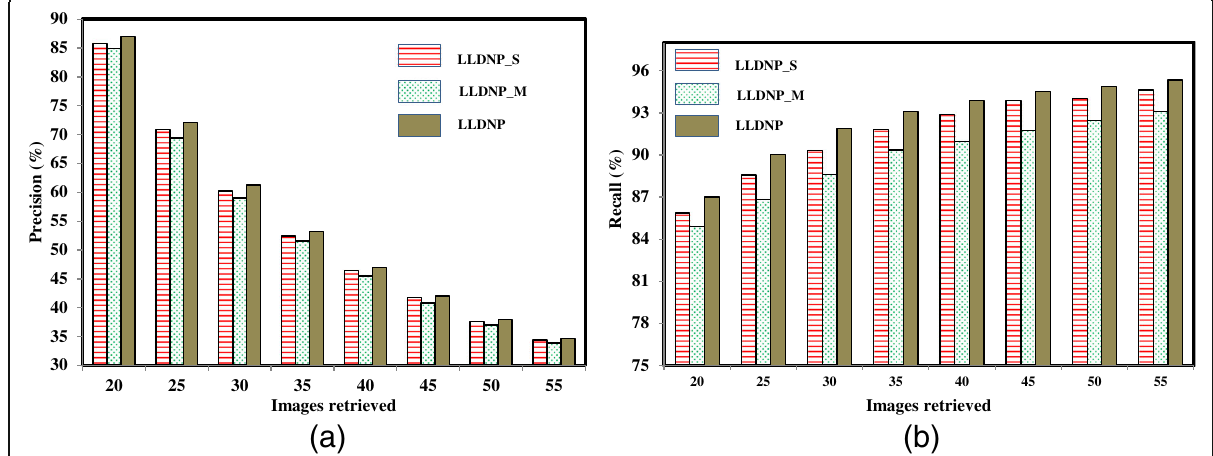
Fig. 9 Comparison of LLDNP_S, LLDNP_M, and LLDNP in terms of a precision and b recall on Outex database. The performance of LLDNP_S is better than LLDNP_M. But LLDNP shows higher performance than LLDNP_S and LLDNP_M in terms of precision and recall on Outex